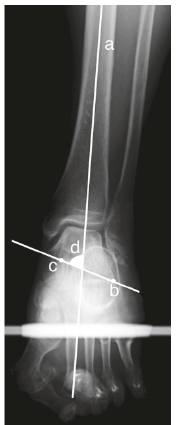
Figure 3: The measurement of the V-V angle. Line a indicates the long axis of the tibia. Point b indicates the lateral extremity of the calcaneus at the posterior surface of the talocalcaneal joint. Point c indicates the superior margin of the sustentaculum tali. Angle d is the V-V angle. Figure 3 is reproduced from Takenaka et al. 2015